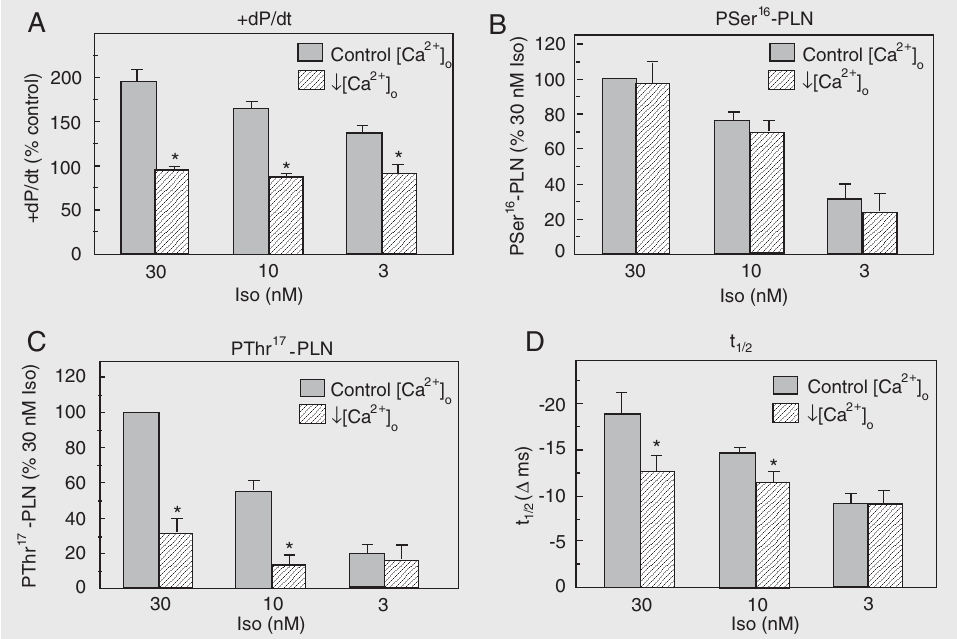
Figure 4. Effects of decreasing (Ca 2+ ) o on mechanical parameters and phospholamban (PLN) phosphorylation sites at different isoproterenol (Iso) concentrations. A , Ca 2+ supply to the heart was decreased so as to abolish the Iso-induced positive inotropic effect at the different concentrations. (Ca) o was 0.25 mM at 30 and 10 nM Iso and 0.50 mM at 3 nM Iso. Contractility was evaluated by the maximal rate of rise in pressure (+dP/dt). Phosphorylation of Ser 16 of PLN (PSer 16 -PLN), induced by the different concentrations of Iso, was not affected by the decrease in (Ca 2+ ) o (B); however, this decrease, reduced the phosphorylation of Thr 17 (C) as well as the isoproterenol-induced relaxant effect (decrease in half relaxation time, t 1/2 ) (D), at 30 and 10 nM Iso. At 3 nM Iso the decrease in (Ca 2+ ) o did not affect either the Iso-induced phosphorylation of Thr 17 or the relaxant effect. +dP/dt is expressed as percentage of control values. t 1/2 is expressed as difference from control values ( ∆ ms). Site-specific phosphoryla- tion of PLN is expressed as percent of the signal obtained with 30 nM Iso at 1.35 mM (Ca) o . *P < 0.05 compared to the corresponding Iso concentration at control (Ca 2+ ) o (Student t -test for unpaired observations). Modified from Ref. 15, with